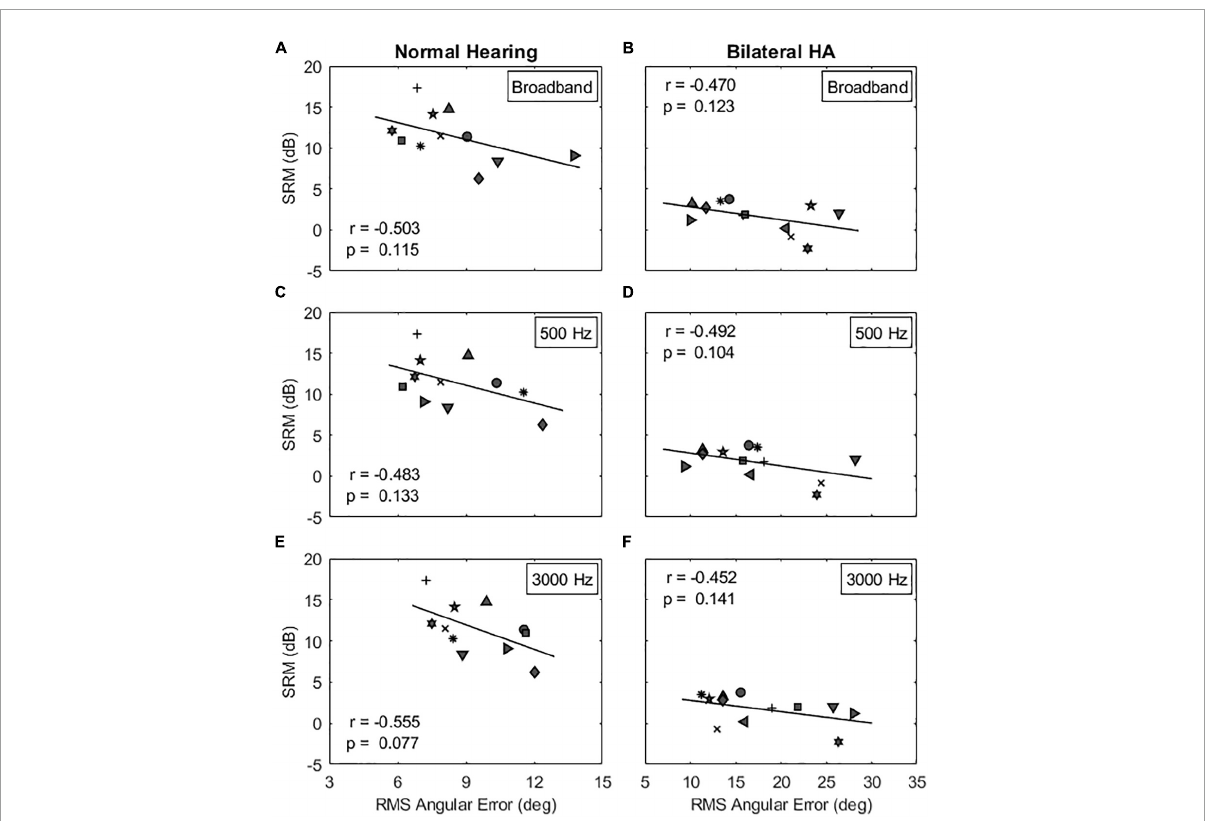
FIGURE7 Correlations between spatial release from masking (SRM) and localization acuity for the same-gender target-maskers condition. The left and right columns show the correlation results for NH and bilateral HA user groups, respectively. The panels (A–F) show the correlation results for the broadband, 500 and 3000 Hz stimulus conditions, respectively. Table 3 shows the correlation results for the different-gender target-maskers condition.